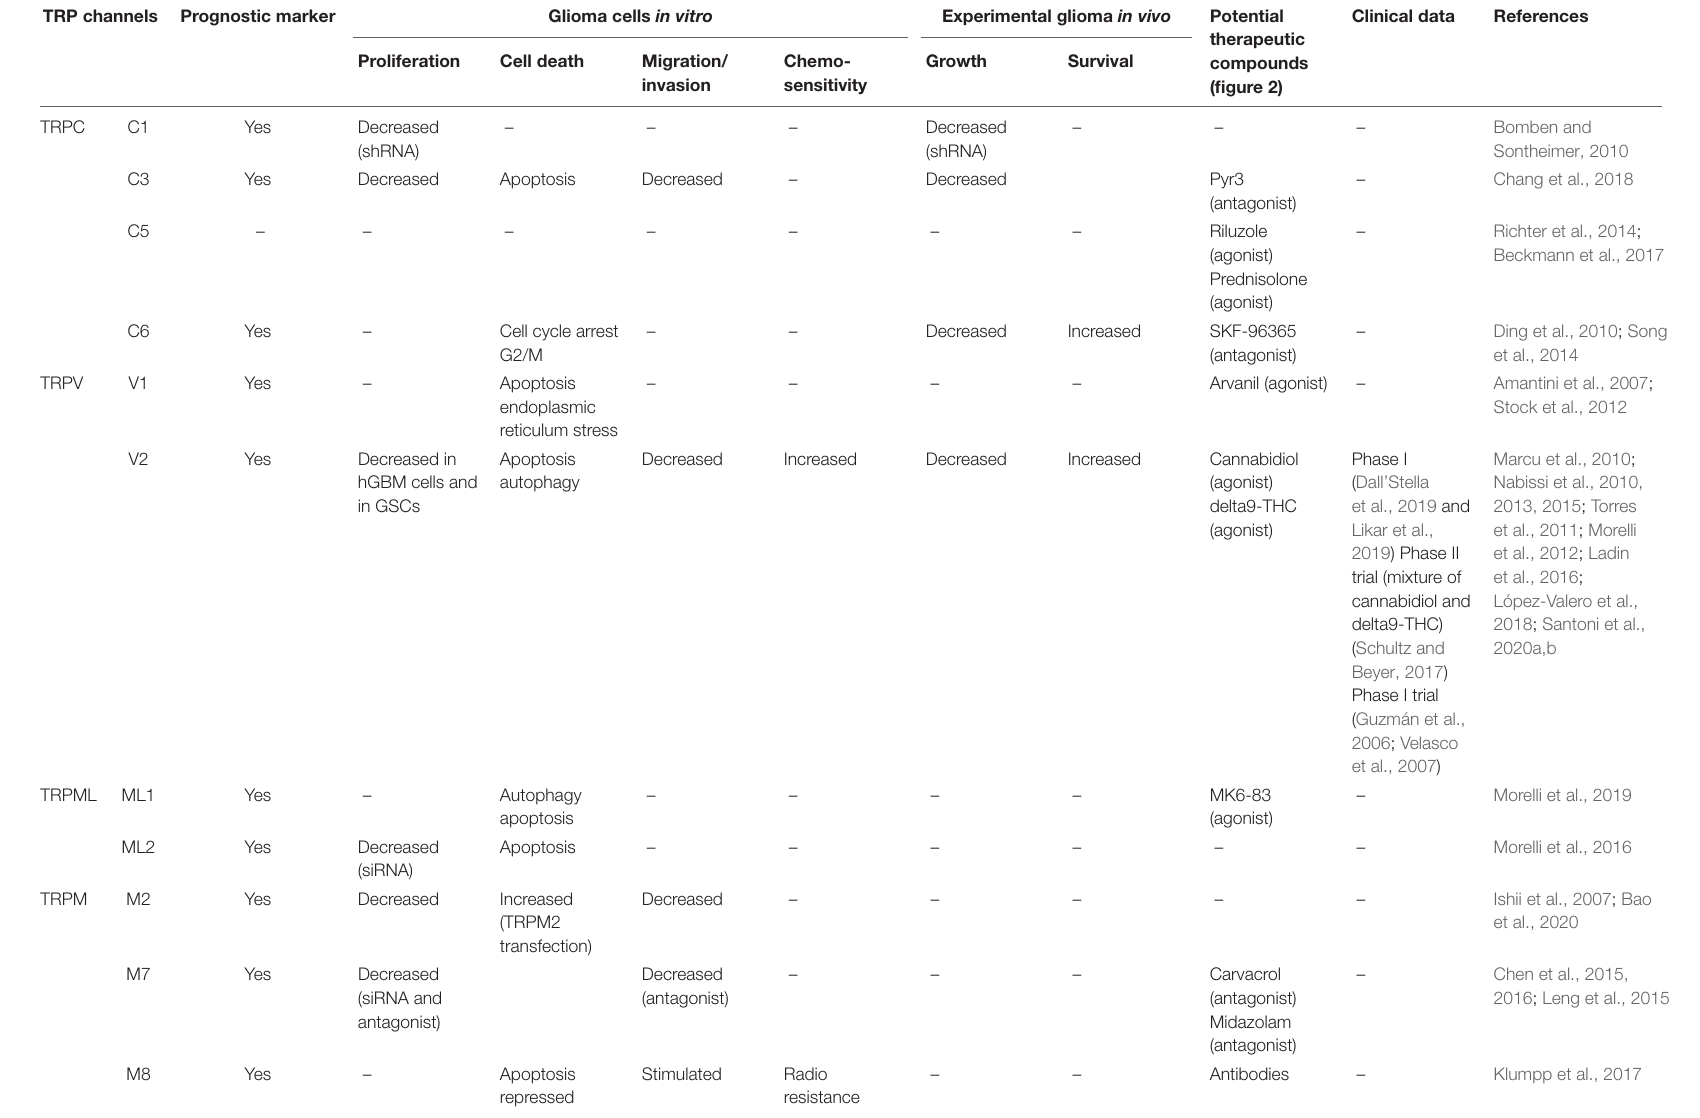
TABLE 1 | TRP ion channels involved in malignant glioma cell death and therapeutic